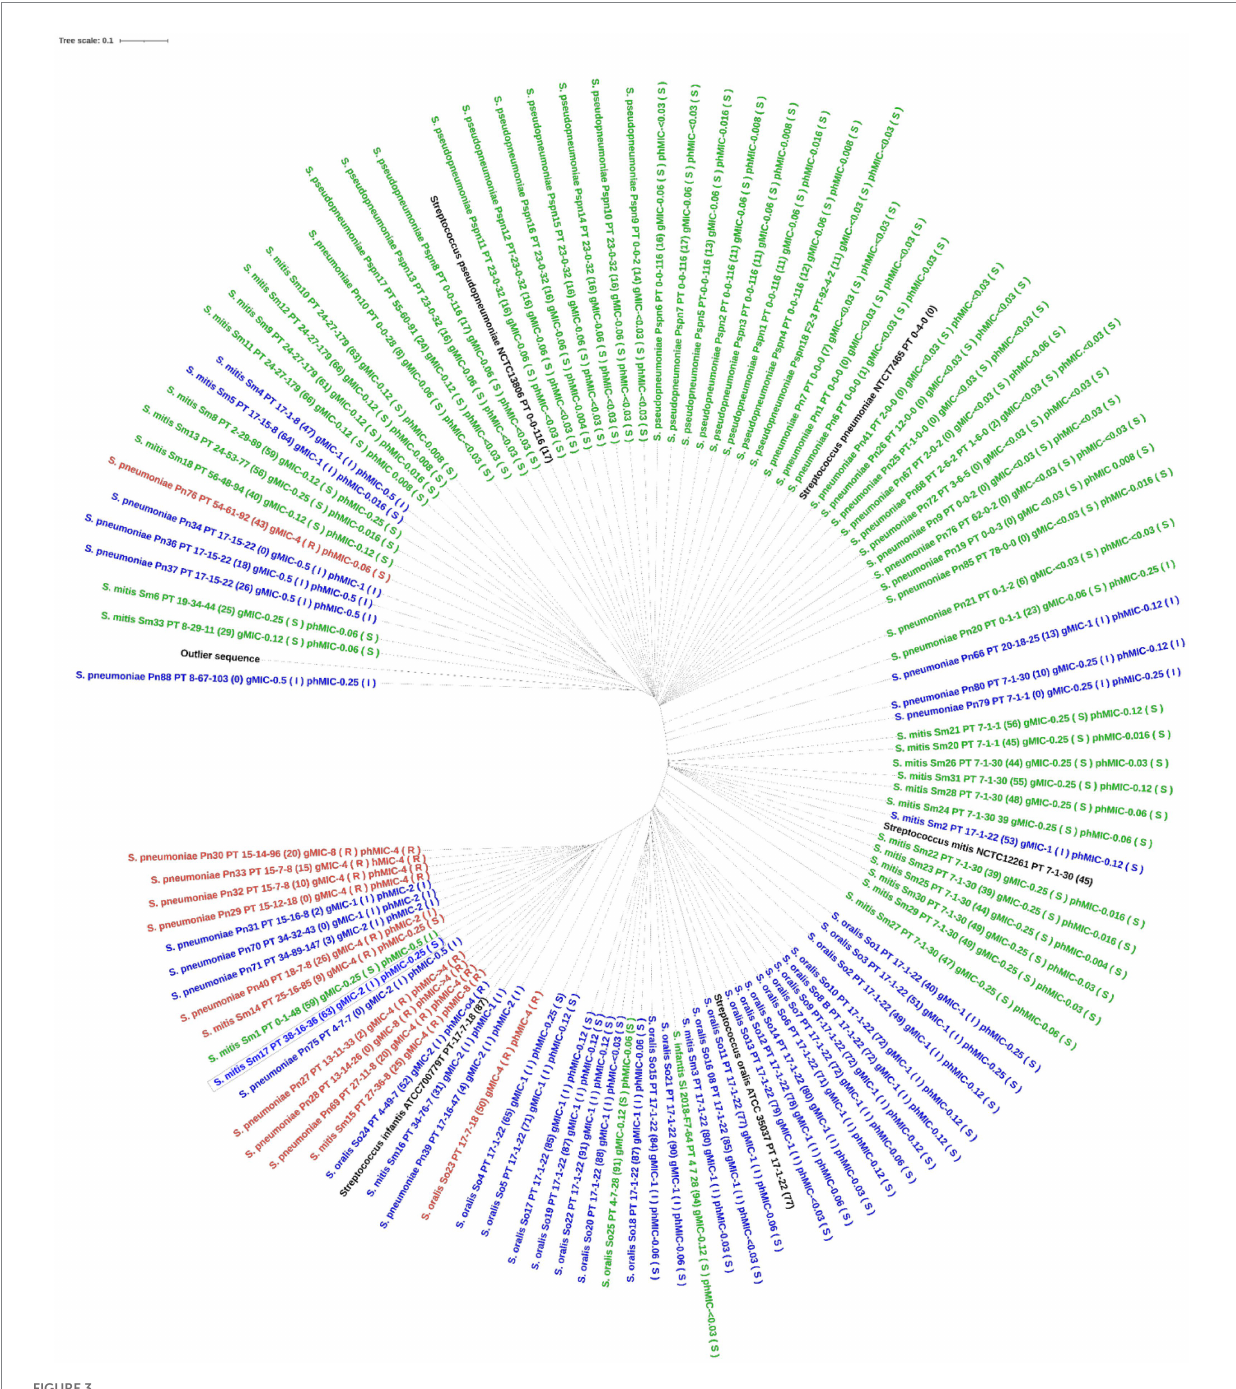
FIGURE 3 Phylogenetic tree of the concatenated PBP amino acid sequence in all mitis group streptococci. The tree was constructed using IQ-TREE software with Blosum62 substitution model. Label contains species and isolate id, nearest PBP-profile (number of PBP amino acid substitutions), genotypic MIC, phenotypic MIC. Tree is colored by genotypic susceptibility (green is susceptible, blue is susceptible increased exposure, red is resistant). The outlier sequence was constructed from Streptococcus dysgalactiae